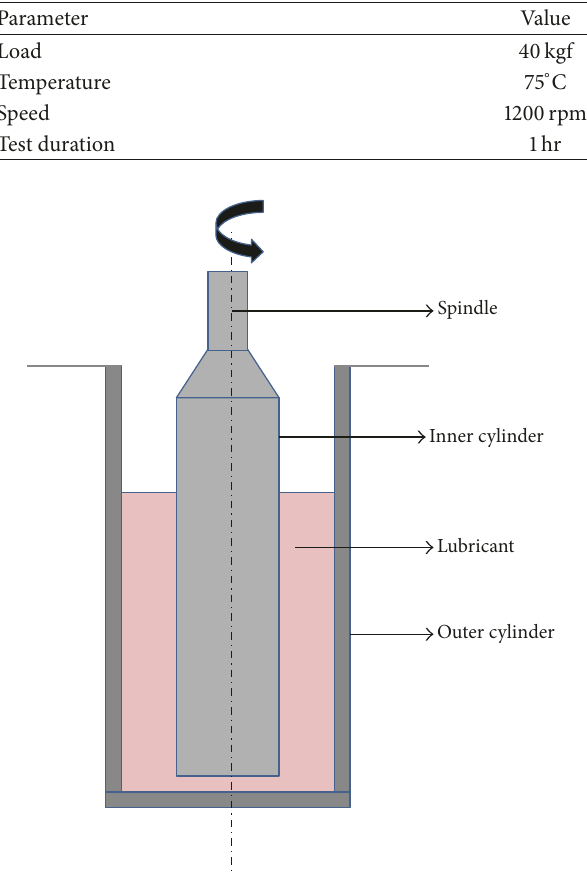
Table 2: Experimental test condition.